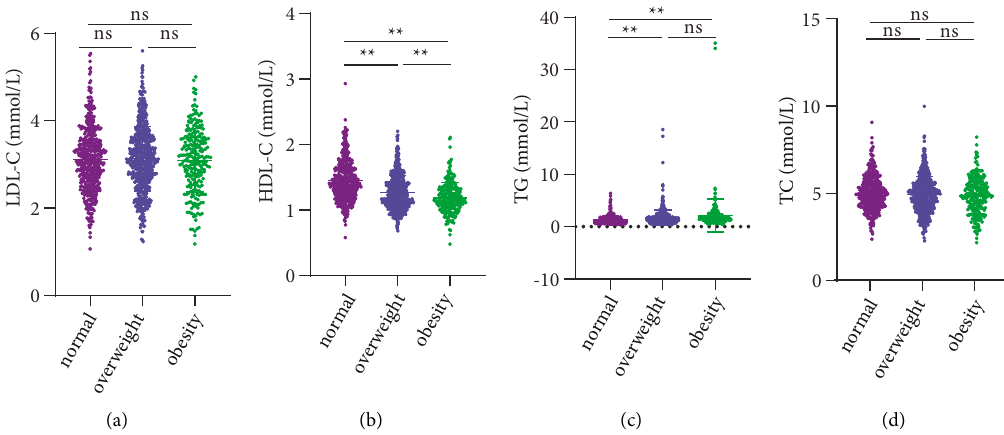
Figure 4: Comparison of lipid indices in normal, overweight, and obese populations. (a) Low-density lipoprotein-cholesterol (LDL-C). (b) High-density lipoprotein-cholesterol (HDL-C). (c) Triglycerides (TG). (d) Total cholesterol (TC). ∗∗ P < 0 . 001 ns P > 0 . 05.